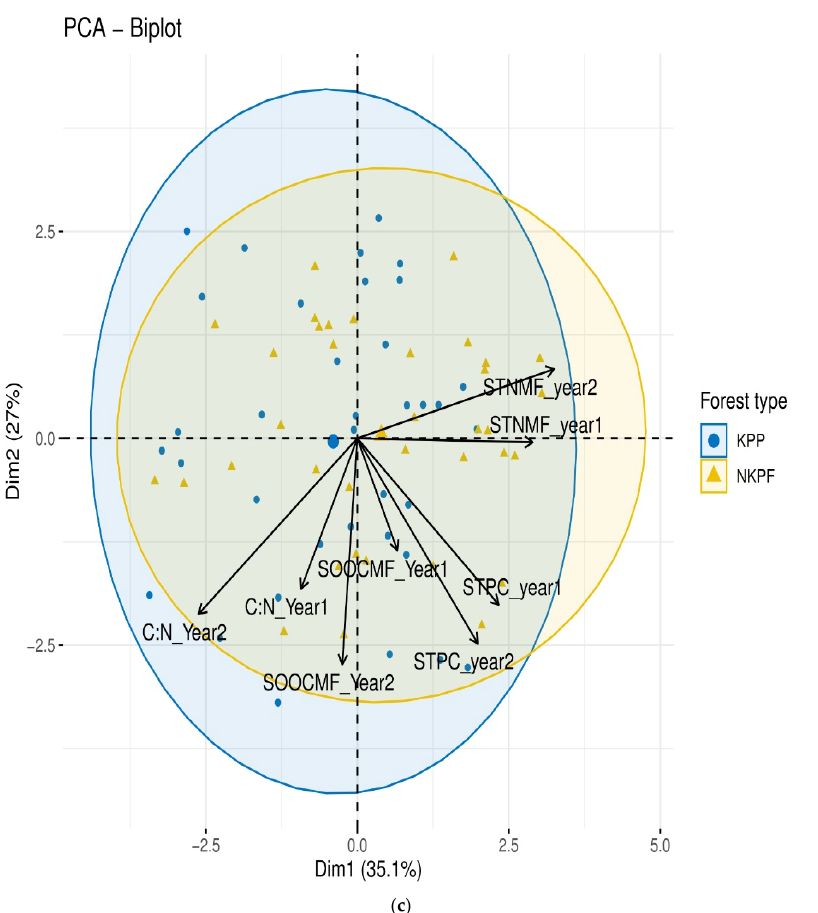
Figure 4. Biplots showing principal component analysis. ( a ) Biplot showing the two principal components and the loading vectors in a single display between litter treatments during the two years of the experiment. The principal component analysis (PCA) for measured parameters shows portioning and grouping of correlated variables. ( b ) Biplot showing the two principal components and the loading vectors between applied treatments (N & P). ( c ) Biplot showing the two principal components and the loading vectors in a single display between two